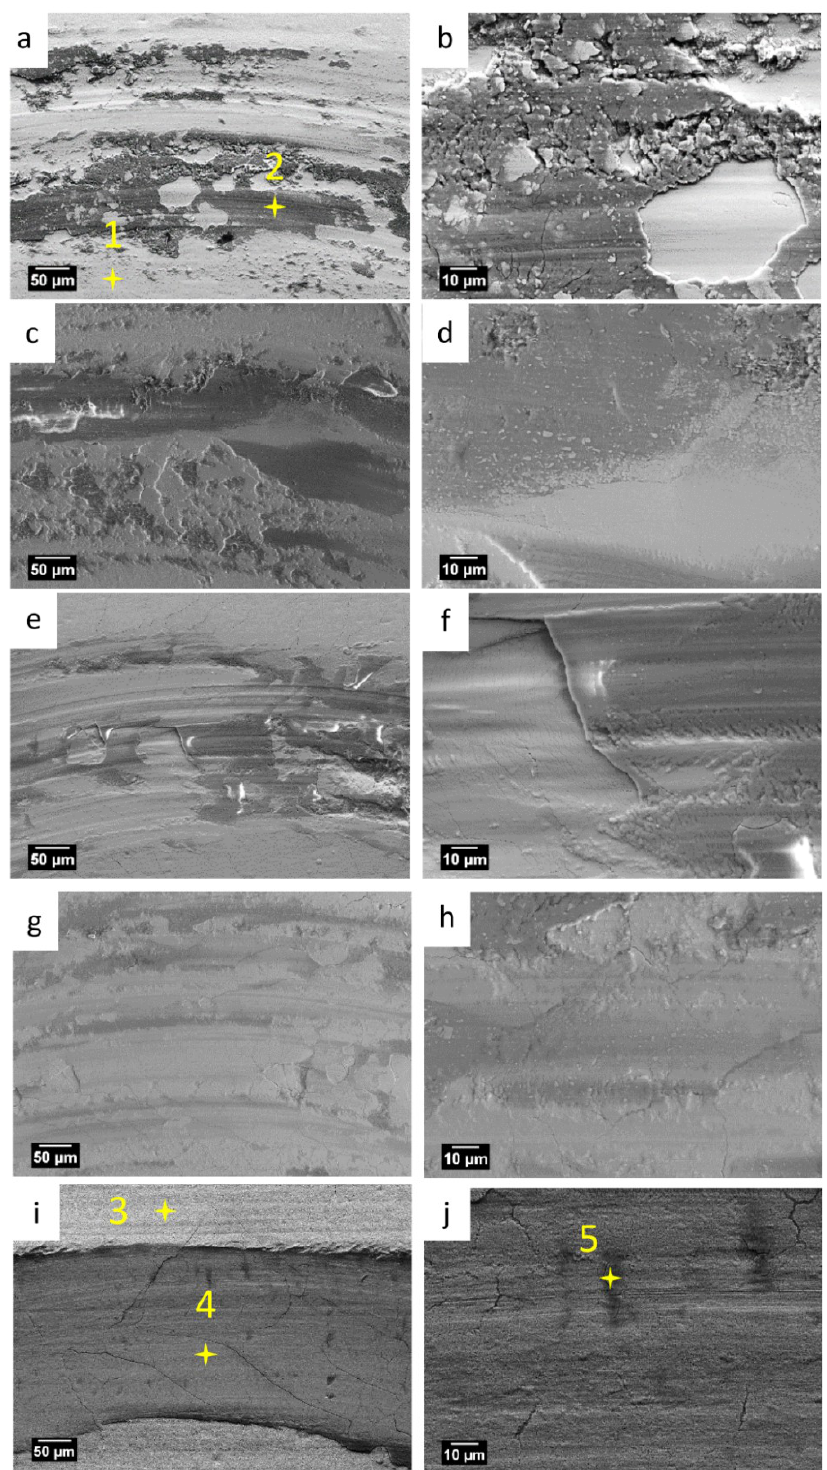
Figure 9. Scanning electron microscope micrographs of the wear track of the Fe-24W coatings in the as-deposited state ( a , b ) and after annealing at 200 °C ( c , d ), 400 °C ( e , f ), 600 °C ( g , h ) and 800 °C ( i , j ). The different representative areas where the EDS point analyses were performed are highlighted with the numbering 1 to 5, and the results are collected in Table 1. Table 1. Chemical composition as obtained by Energy Dispersive X-ray Spectroscopy (EDS) point analysis at locations shown in Figure 9.